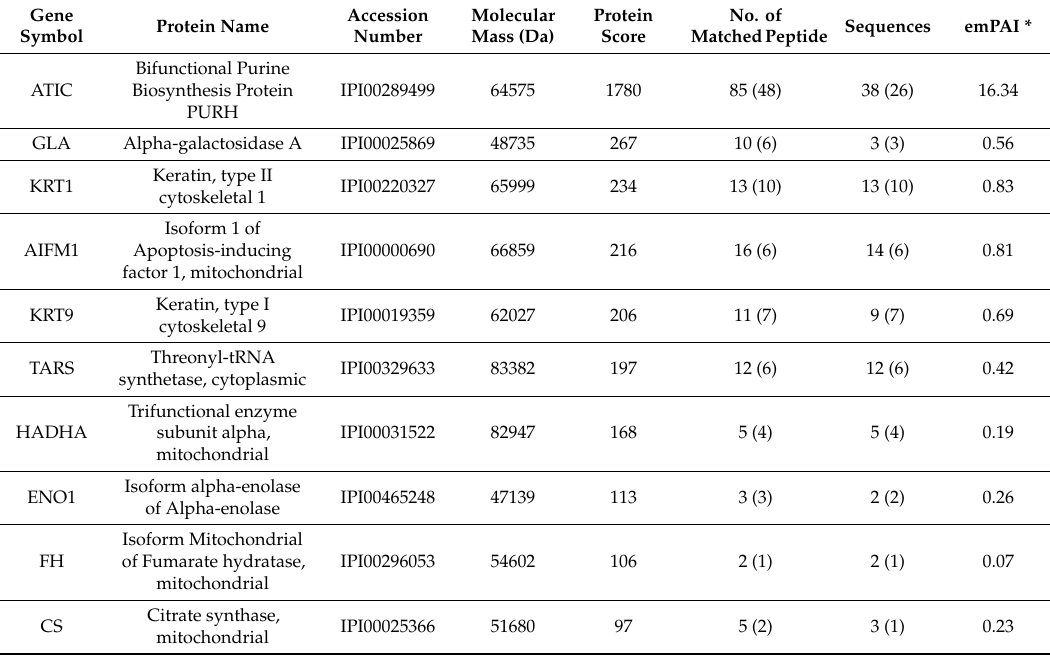
Table 1. Mass spectrometric analysis of XC154